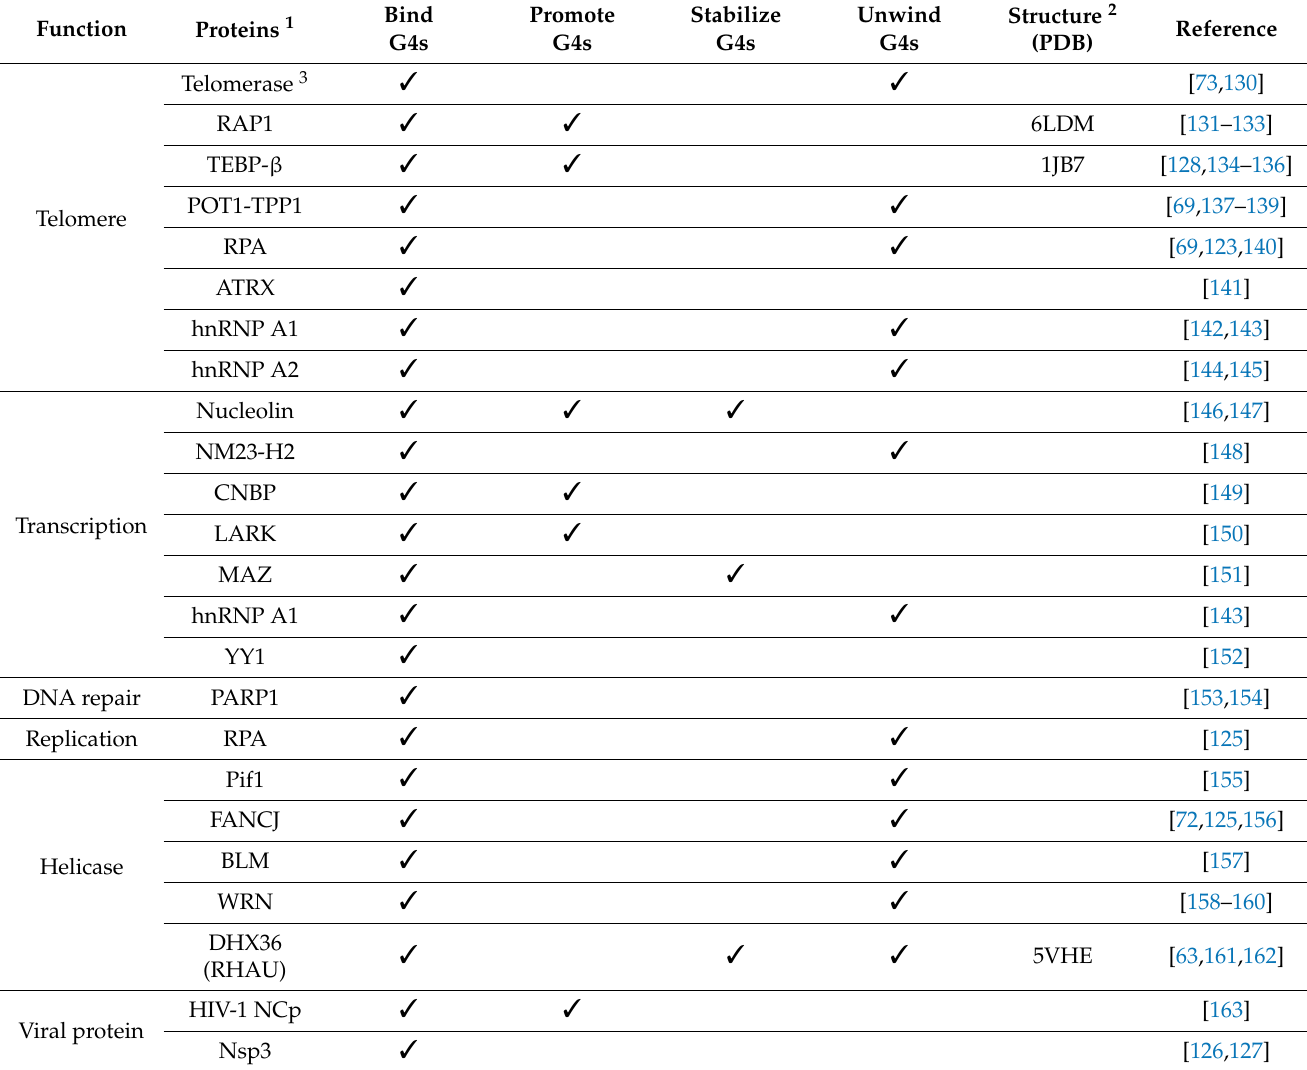
RAP1, repressor activator protein 1; TEBP, telomere end-binding protein; POT1-TPP1, protection of telomeres 1-telomere protection protein 1; RPA, replication protein A; ATRX, alpha-thalassemia/mental retardation syndrome X-linked; hnRNP, heterogeneous nuclear ribonucleoprotein; CNBP, cellular nucleic-acid-binding protein; MAZ, myc-associated zinc-finger; YY1, Yin and Yang 1;